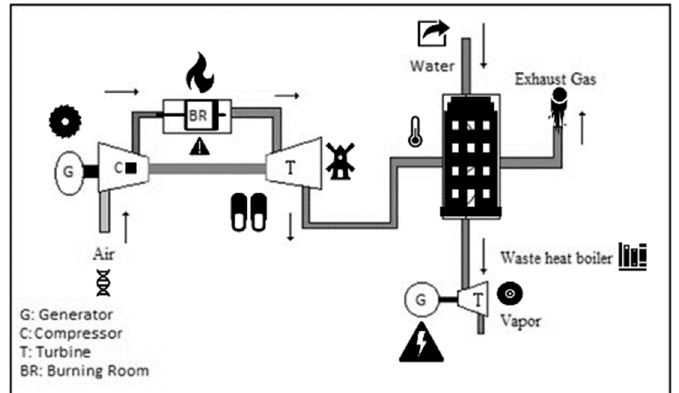
Figure 1. Schematic representation of the working principle of the combined cycle power plant.